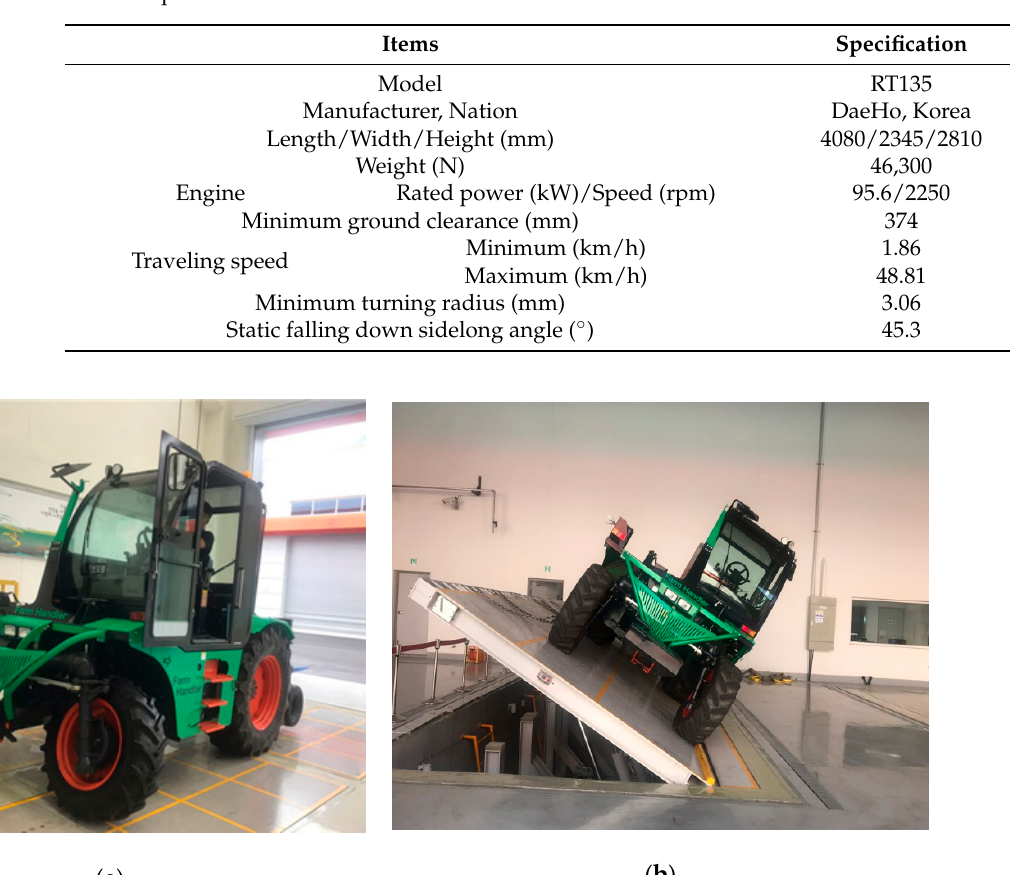
Figure 1. Picture of the tractor used. Table 1. Specifications of the tractor used.